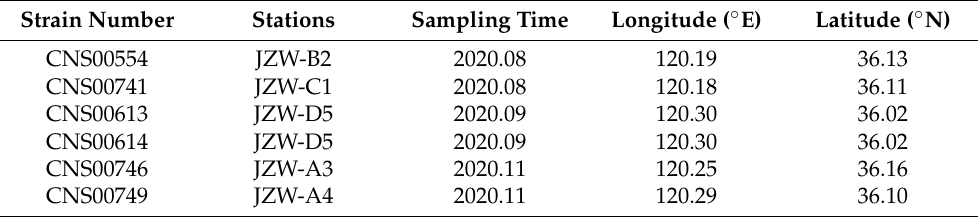
Figure 1. Sampling sites of the six strains of Coscinodiscus granii. Sampling sites are marked by blue shapes. Table 1. The sampling station information of the six Coscinodiscus granii strains.